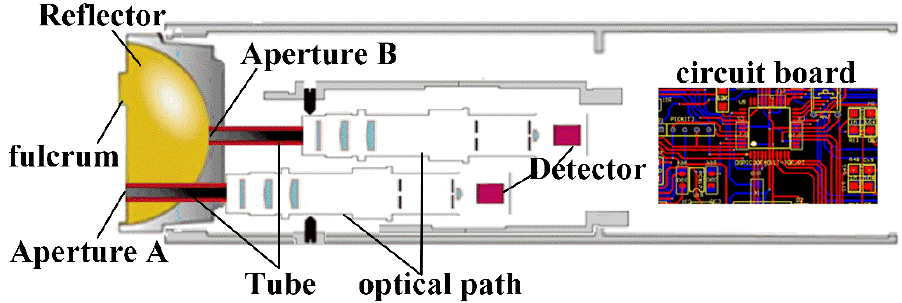
Figure 2. Structure diagram of the pyrometer based on reflector with two apertures.